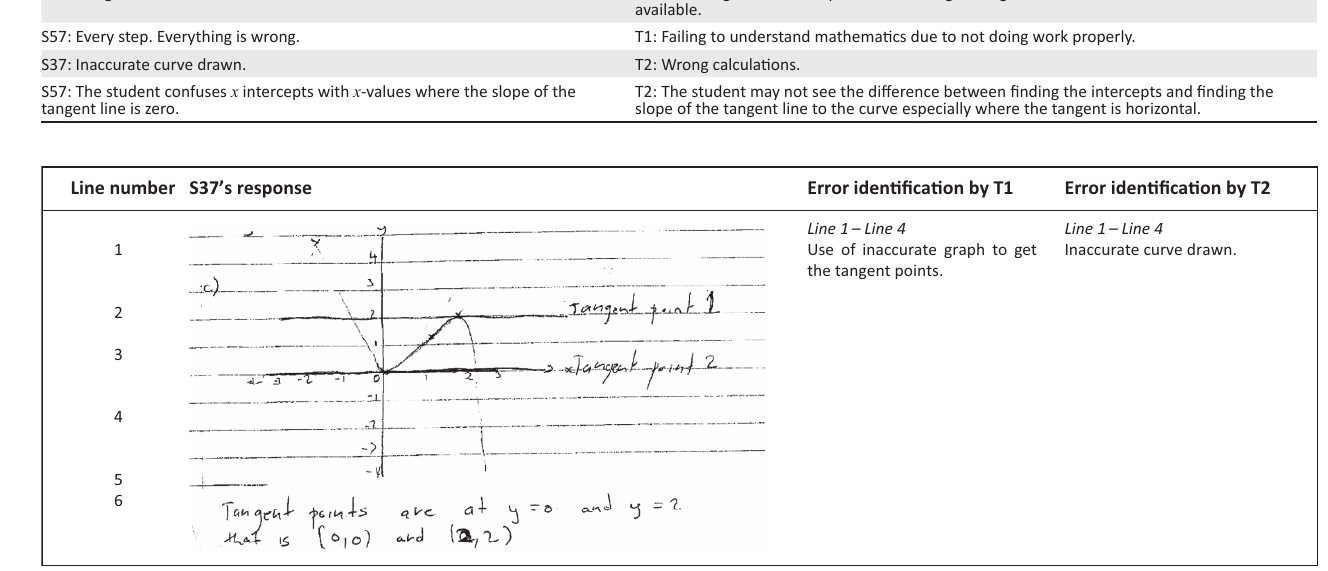
Figure 5: Error identification in S37’s